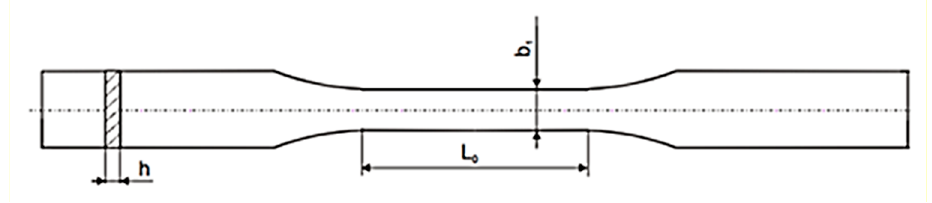
Figure 10. Shape of samples with dimension markings.